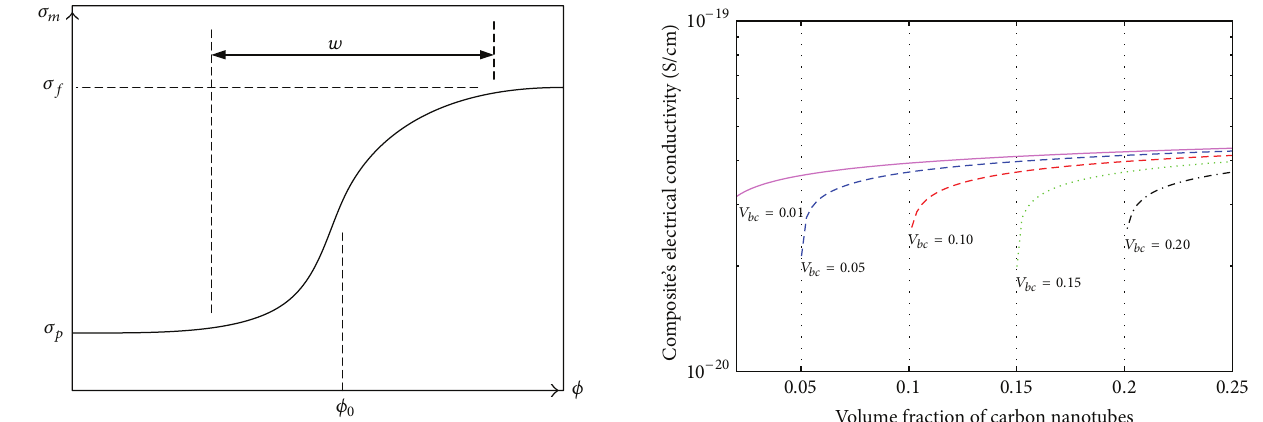
Figure6:DCelectricalconductivityofthenanocompositewhenthe percolation threshold of the filler is varied (Kirkpatrick’s